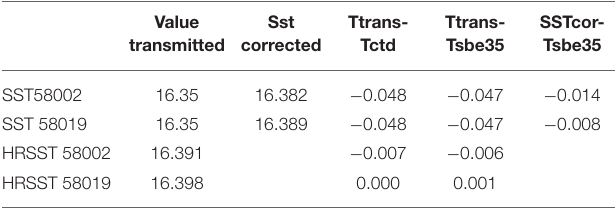
TABLE 6 | Results of the comparison made at sea, between buoys transmitted values, CTD and SBE 35 measurements. Value